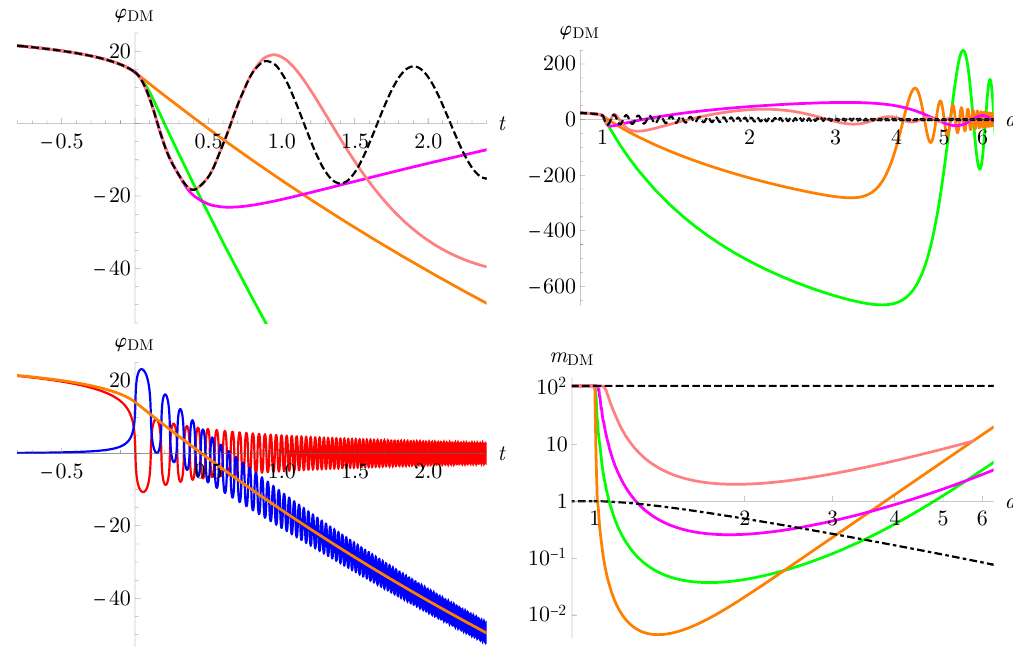
Figure 3 . Time evolution of the dark matter (cid:12)eld and its mass for a case with an in(cid:13)aton mass at the vacuum m (cid:30) 0 (cid:25) 10 4 H end , zero-temperature axion mass m (cid:27) 0 (cid:25) 10 2 H end , and strong coupling scale (cid:3) = 10 (cid:0) 1 (cid:1) (3 M 2 H 2 ) 1 = 4 . The decay width of the reheaton is varied as (cid:0) RH =H end (cid:25) 4 (orange Pl end line), 0 : 7 (green), 0 : 2 (magenta), 0 : 04 (pink), and 0 (black dashed). The bottom left panel further shows (cid:27) (blue) and (cid:11)(cid:30) (red), and the bottom right panel shows H (black dot-dashed). The value of ’ DM is normalized by (cid:11)M Pl H end =m (cid:30) 0 , while m DM is normalized by H end . Time t is in units of 2 (cid:25)=m (cid:27) 0 , and the end of in(cid:13)ation is set to t end = 0 and a end = 1. See the text for more